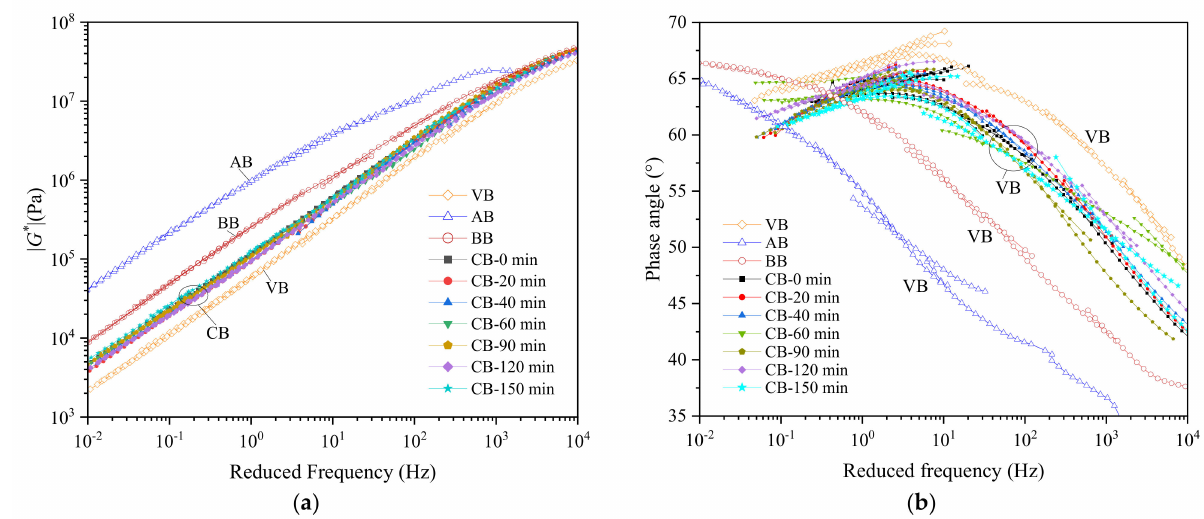
Figure 9. Shear modulus and phase angle of various binders. ( a ) Master curve of shear modulus; ( b ) Master curve of phase angle.